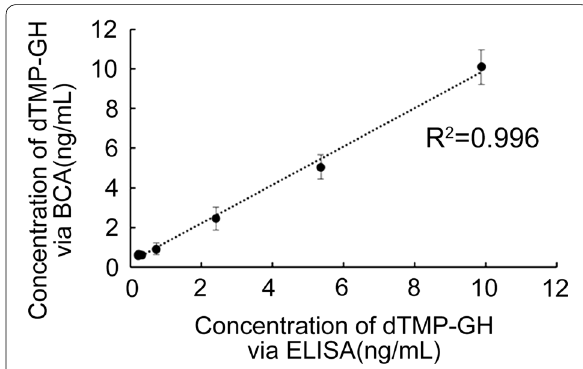
Fig. 4 Correlation between ELISA and BCA assays for detection of diluted dTMP-GH